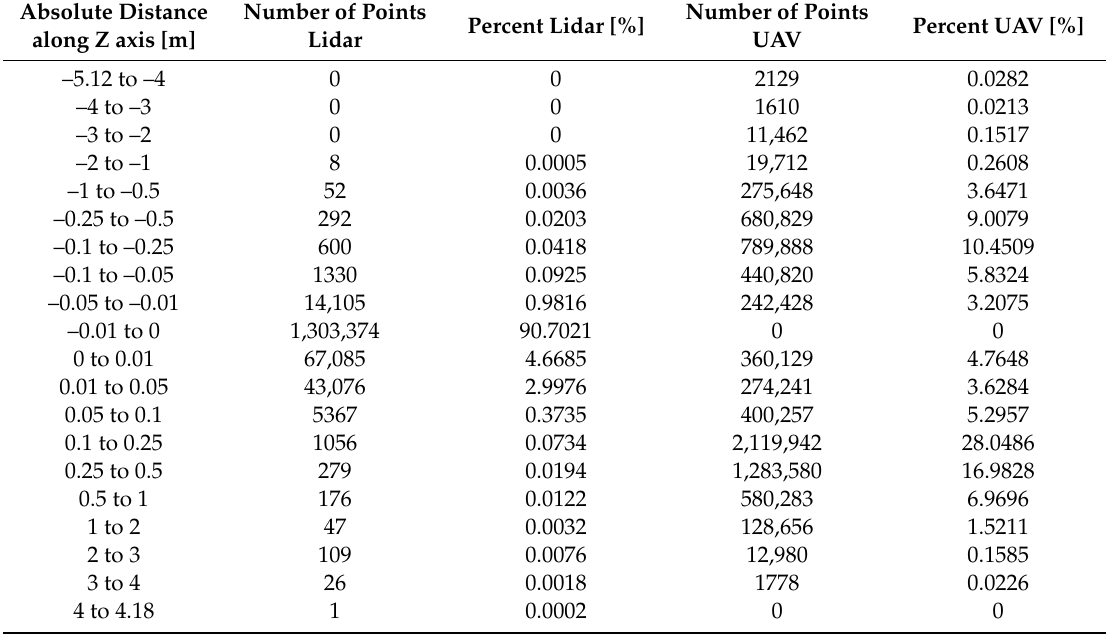
Table 6. Distribution of points based on cloud-to-cloud (C2C) distance for LiDAR and UAV point clouds. Absolute